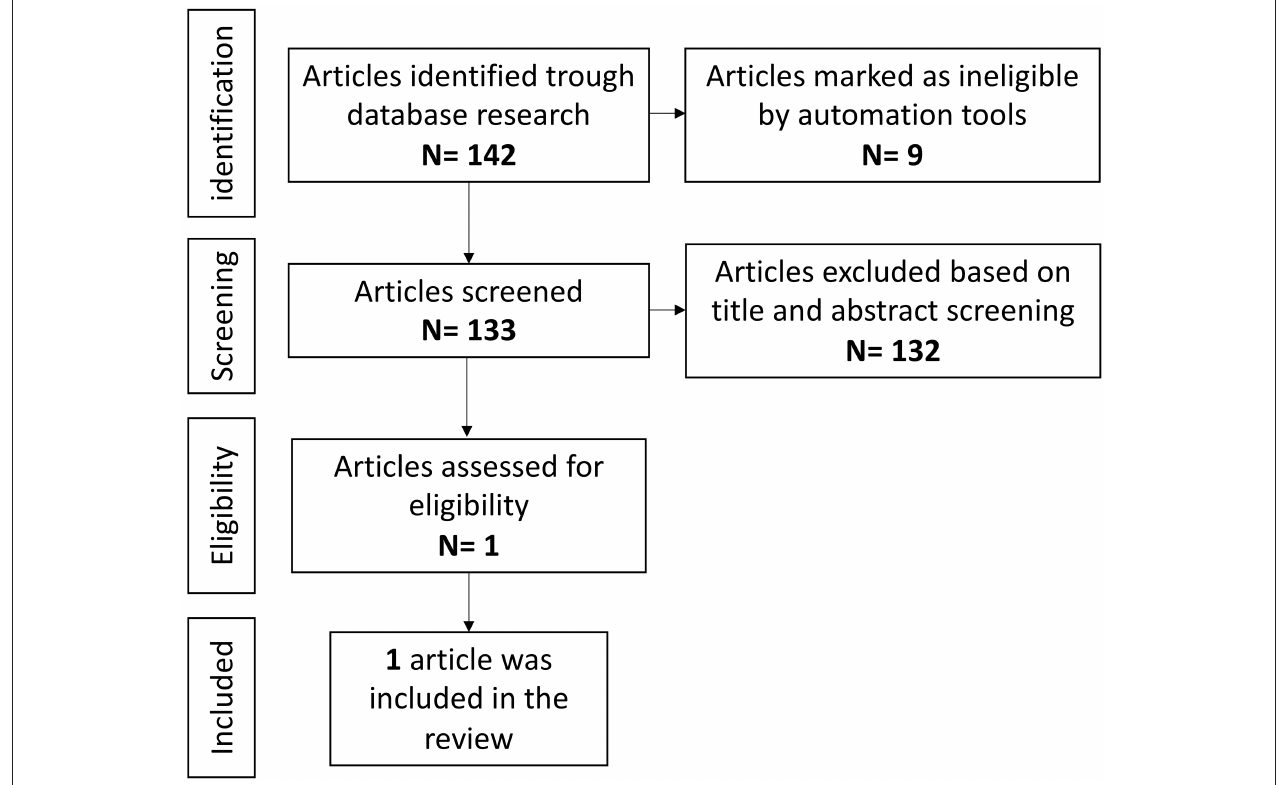
FIGURE 5 | Anti-TNF agents and epilepsy, literature